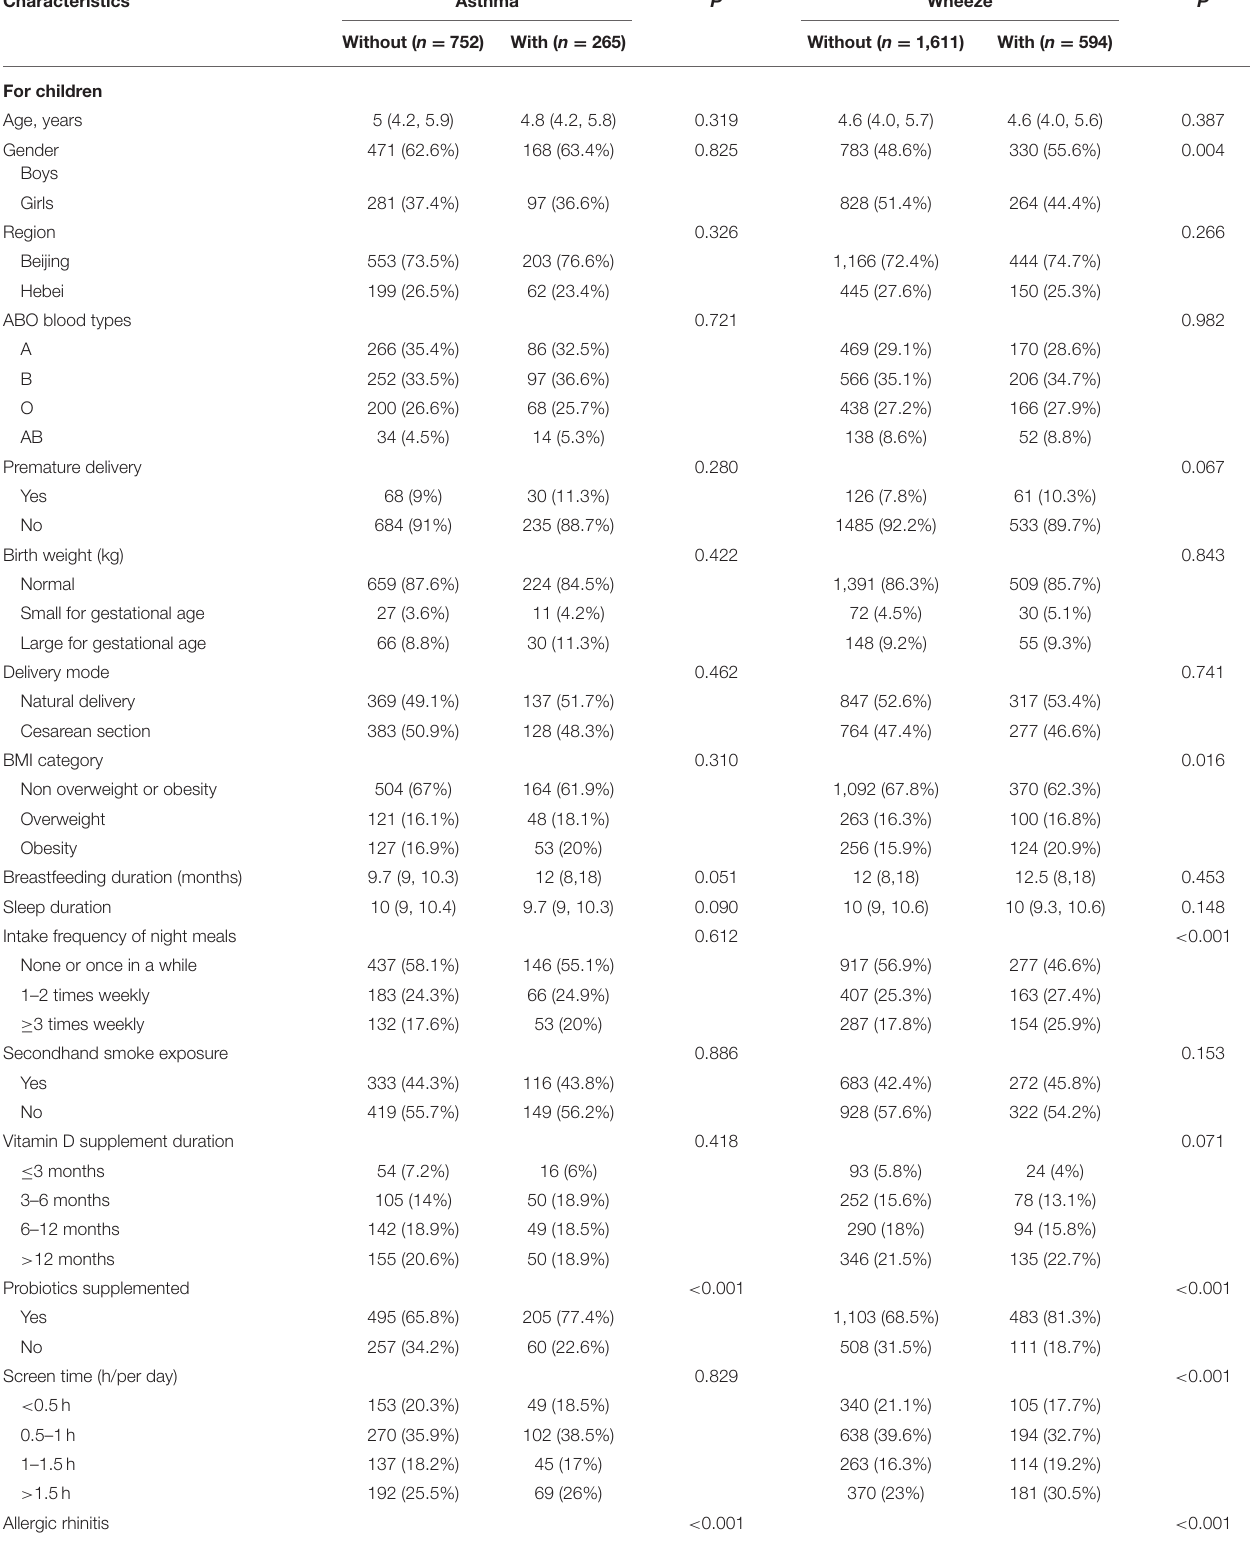
TABLE 2 | Baseline characteristics of study participants after propensity score matching in this study.